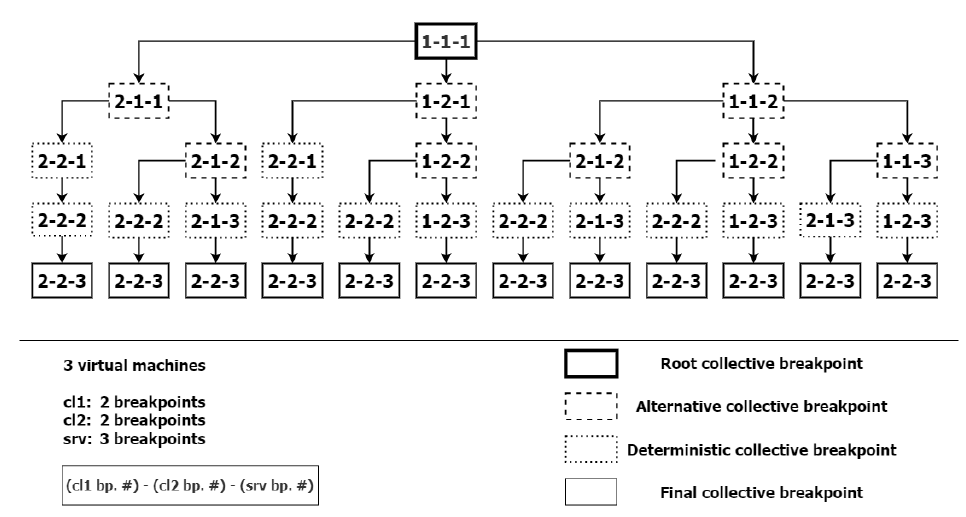
Figure 3. Complete execution tree of example infrastructure with 3 VMs and 7 local breakpoints.